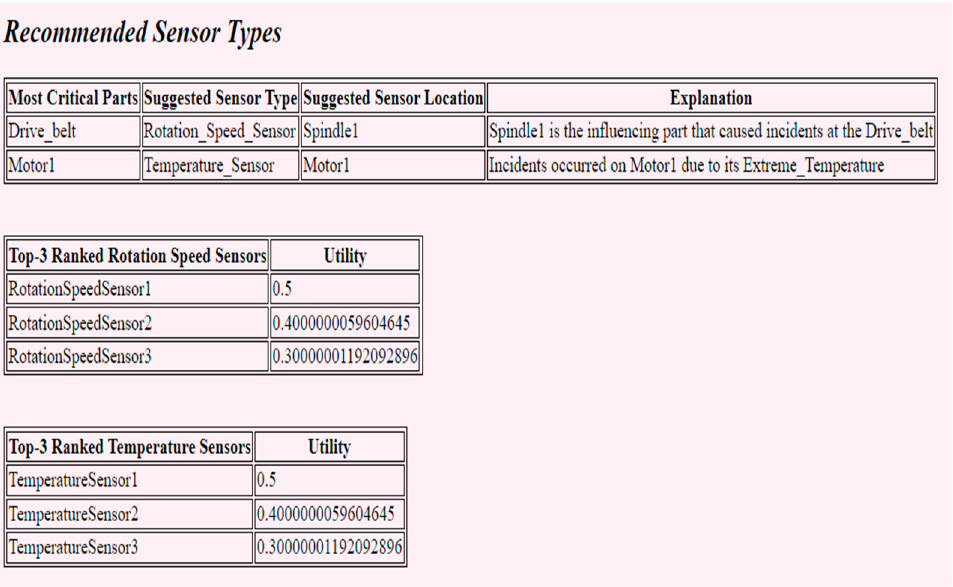
Figure 9. Ranked list of sensor-type instances.